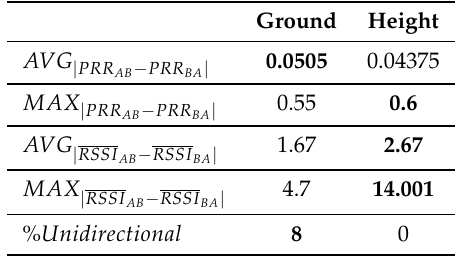
Table 1. Link asymmetry for deployments at height and at ground